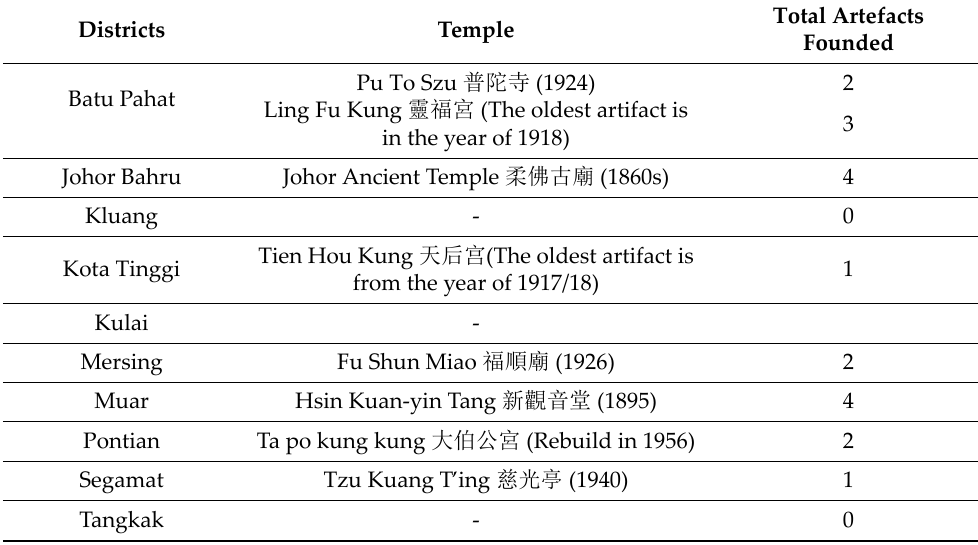
Table 3. Temple and Numbers of Artefacts Recorded by Franke and